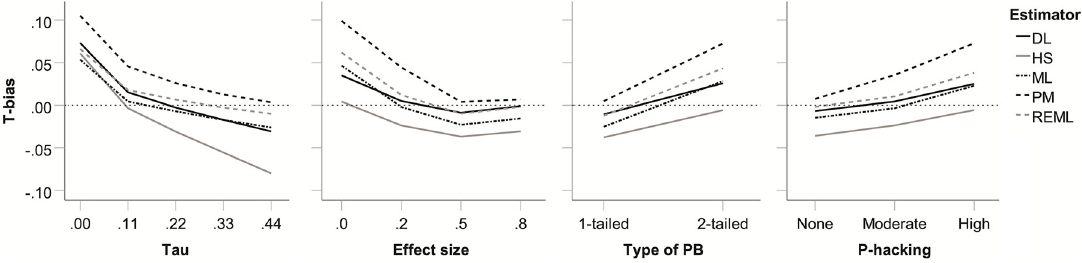
Fig 4. Bias in heterogeneity estimates ( T bias ) for five heterogeneity estimators as a function of true heterogeneity ( τ ), true average effect size ( θ ), type of publication bias, and p -hacking environment, respectively.